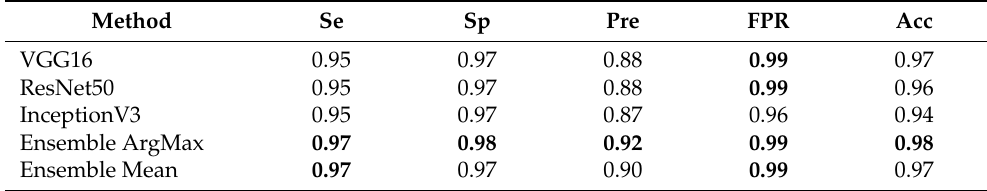
Positive Rate, Acc: Accuracy. The highest values are shown in bold